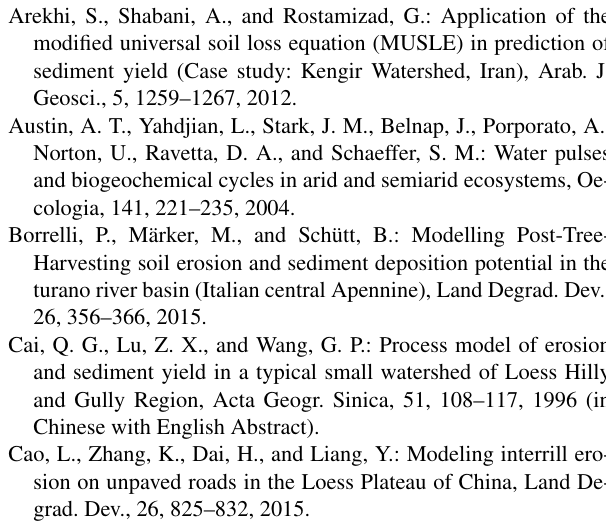
Multi-year average sediment yield decreased from 5803.23 (before model modification) to 4510.66 Mg km − 2 (after model modification) in the Majiagou River